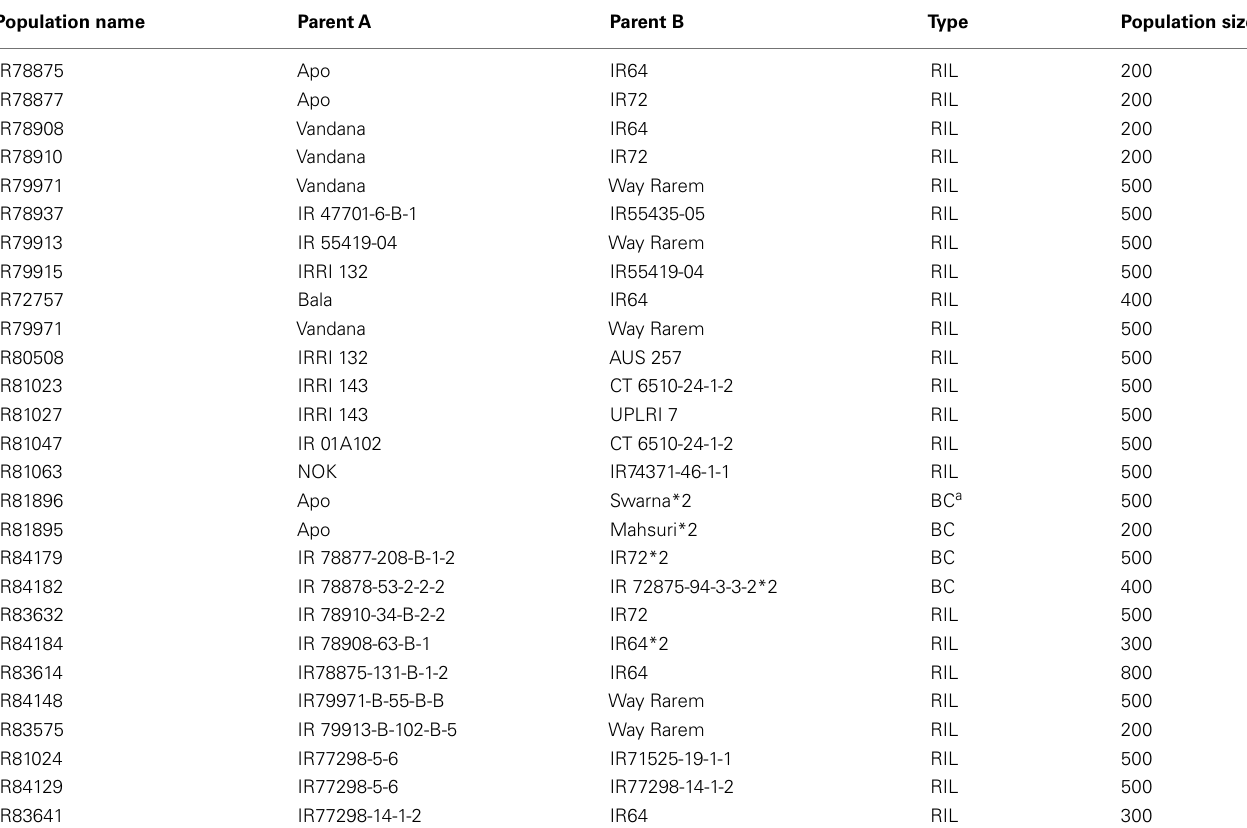
Table 2 | Segregating populations generated by drought breeding programs for genetic analysis and breeding for drought tolerance; genetic stocks maintained at IRRI (Source: information provided byArvind Kumar,